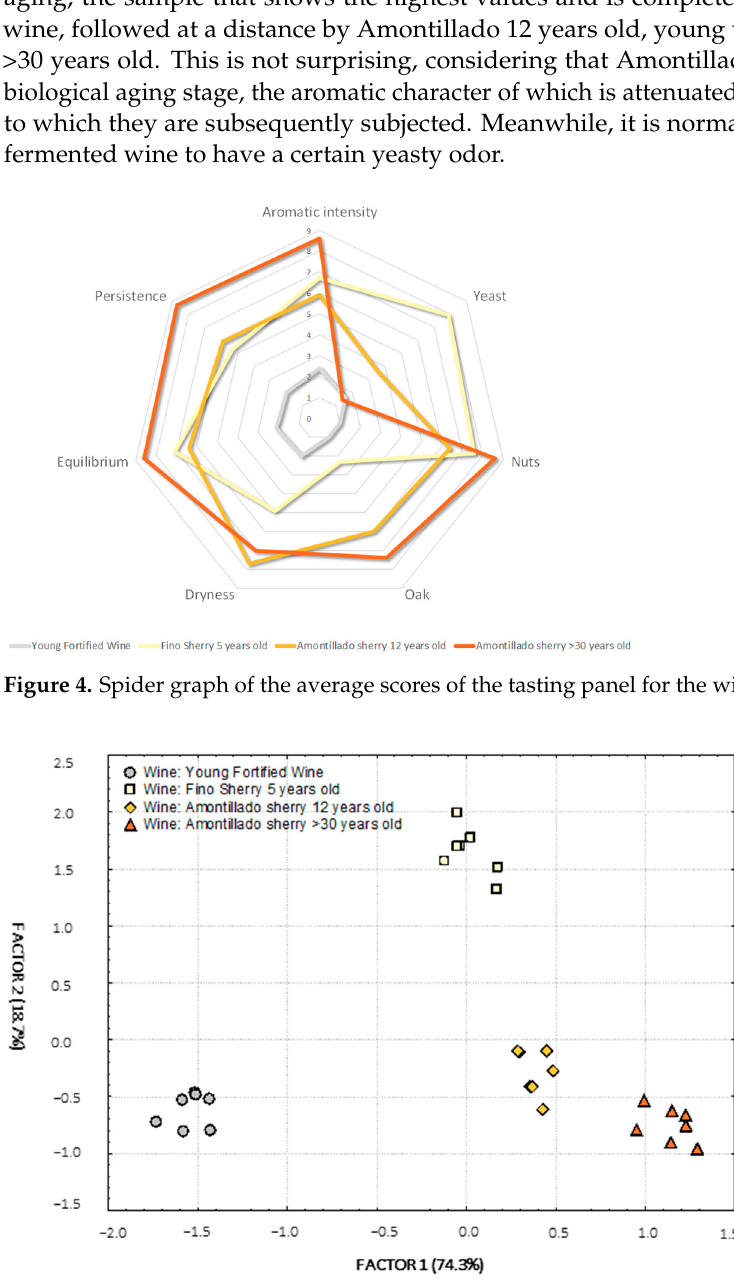
Figure 5. Projection of the wines on the plane of Factors 1 and 2 obtained after factor analysis.